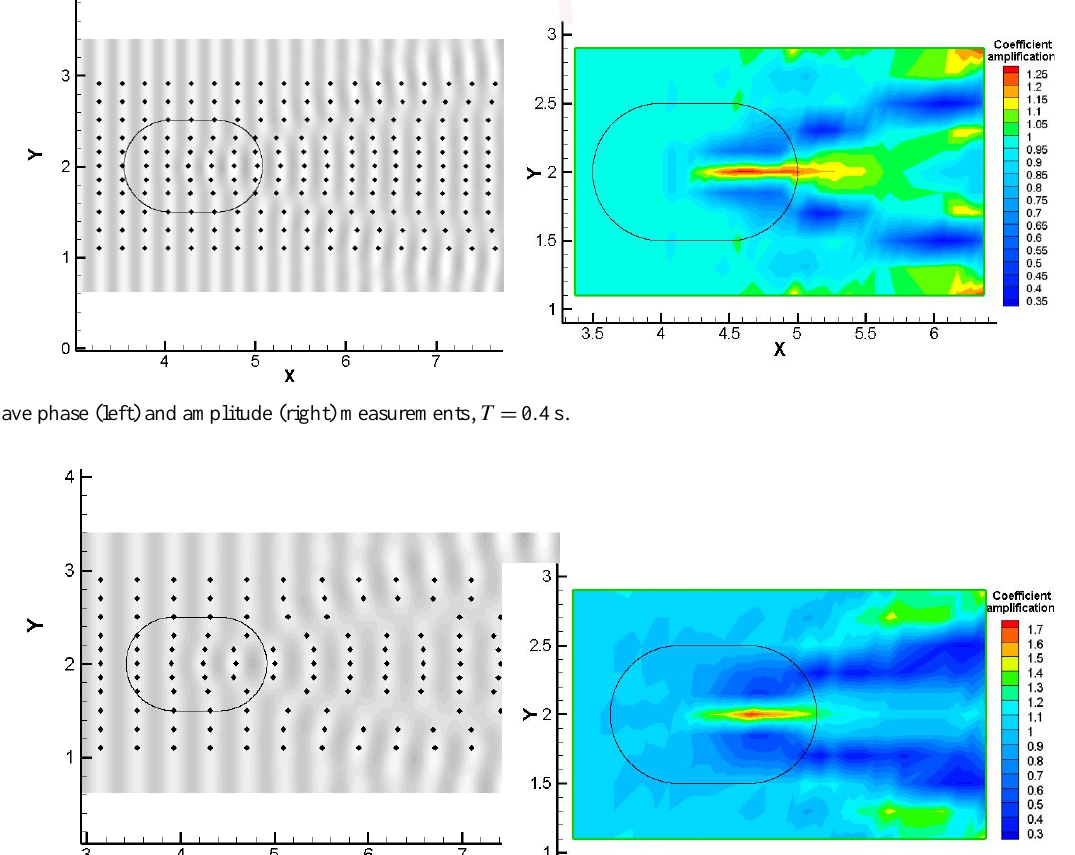
Fig. 9: Wave phase (left) and amplitude (right) measurements, T=0.5s